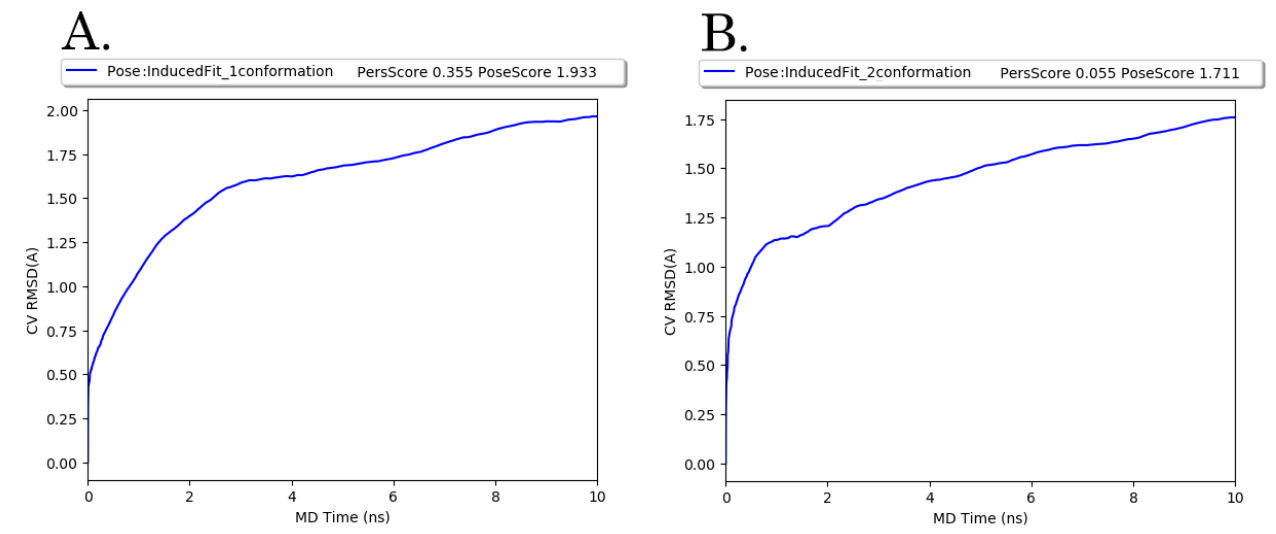
Figure 6. Average RMSD of two EAPC-67 ( A , B ) tautomers conformation over 10 × 10 ns metady- namics runs with calculated values of PoseScore and PersScore.